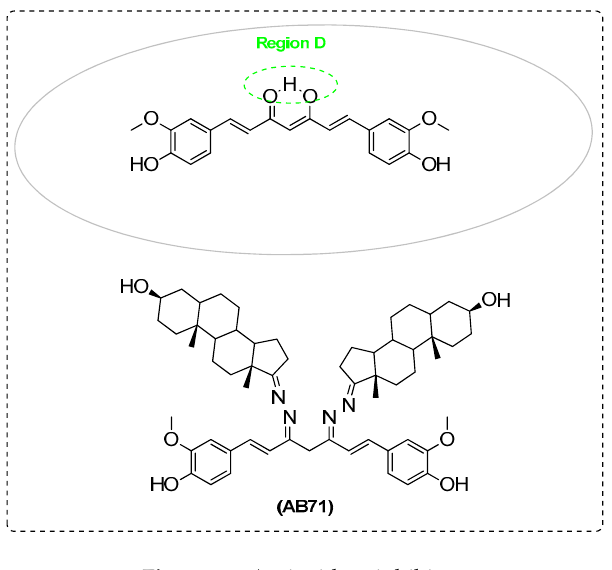
Figure 12. inhibitor. Figure 12. Antioxidant inhibitor.